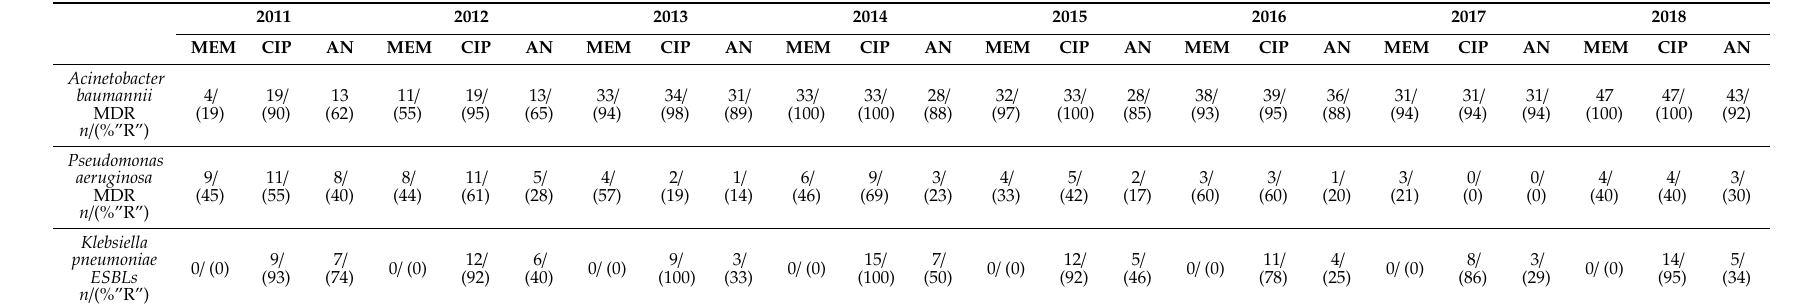
Table 3. Percentage of resistance of selected “alert pathogens” to three groups of antibiotics in the observed